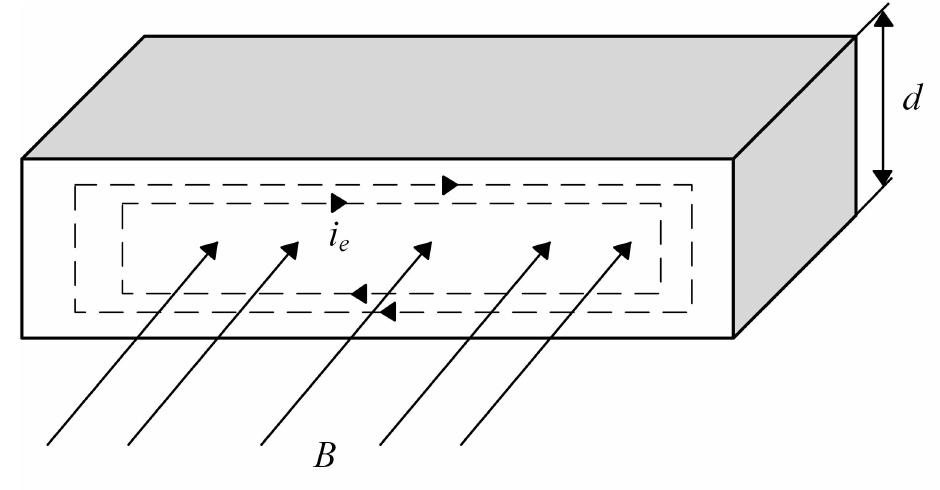
Figure 2. Cause of the Eddy Current Loss.